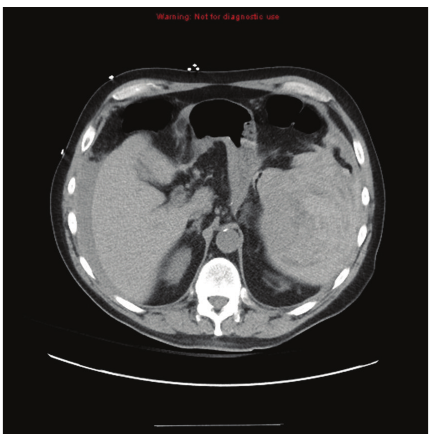
Figure 1: Axial view of splenic rupture and hematoma.